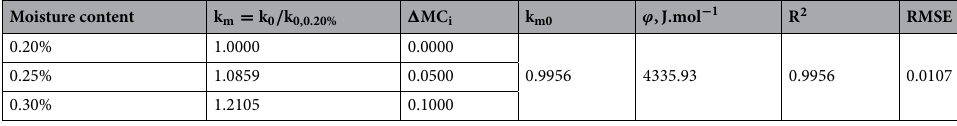
Table 5. Arrhenius constants and activation energy based on rate constant dependency on moisture content.